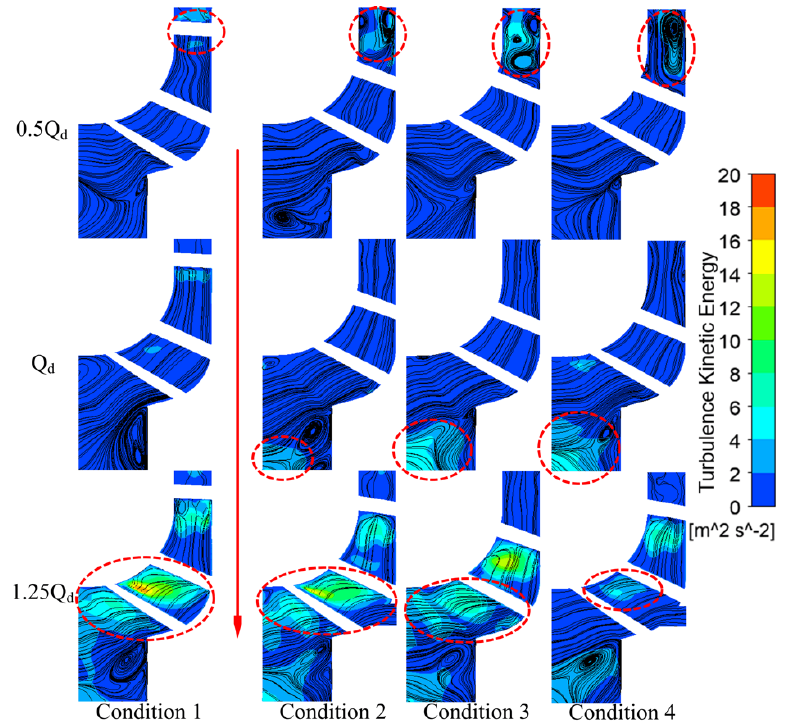
Figure 14 . Turbulent kinetic energy distributions in the turbine’s meridian section. Figure 14. Turbulent kinetic energy distributions in the turbine’s meridian